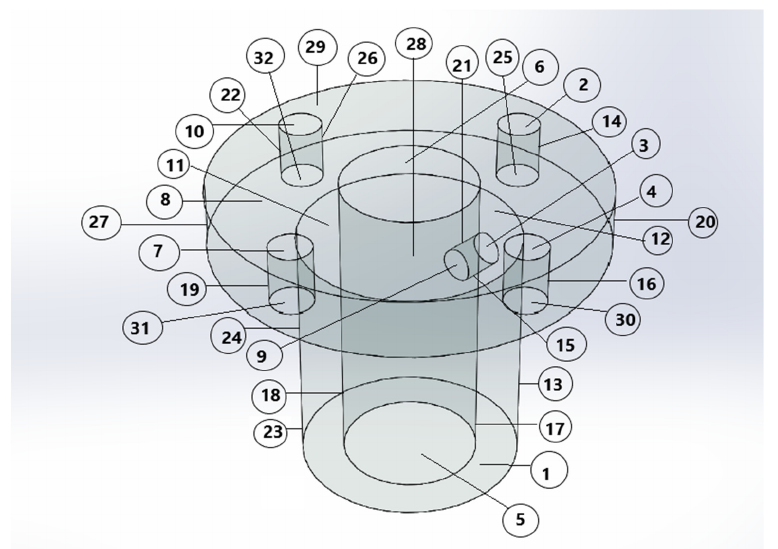
Figure 20. The faces of the part.